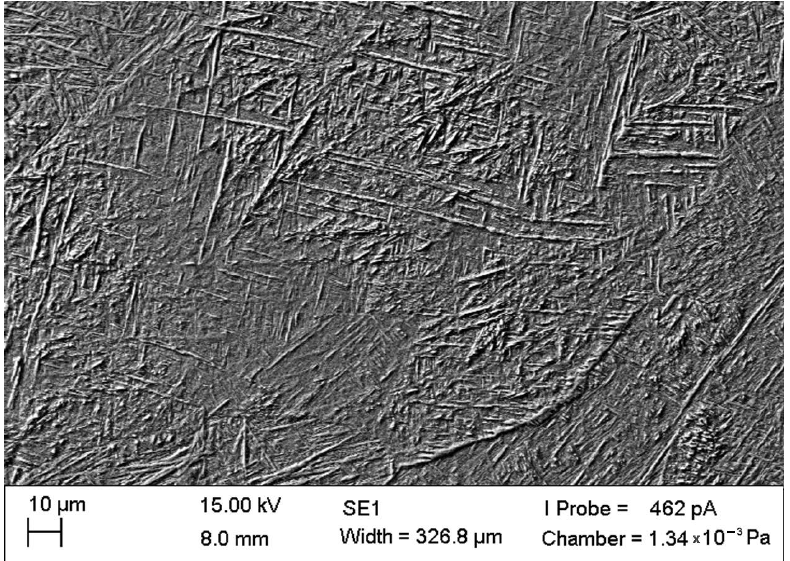
Figure 4. Microstructure of the Ti ‐ 6Al ‐ 4V titanium alloy after the selective laser melting (SLM) process (scanning microscopy). Distribution of α ’ ‐ phase lath martensite on the background of the β‐ phase.